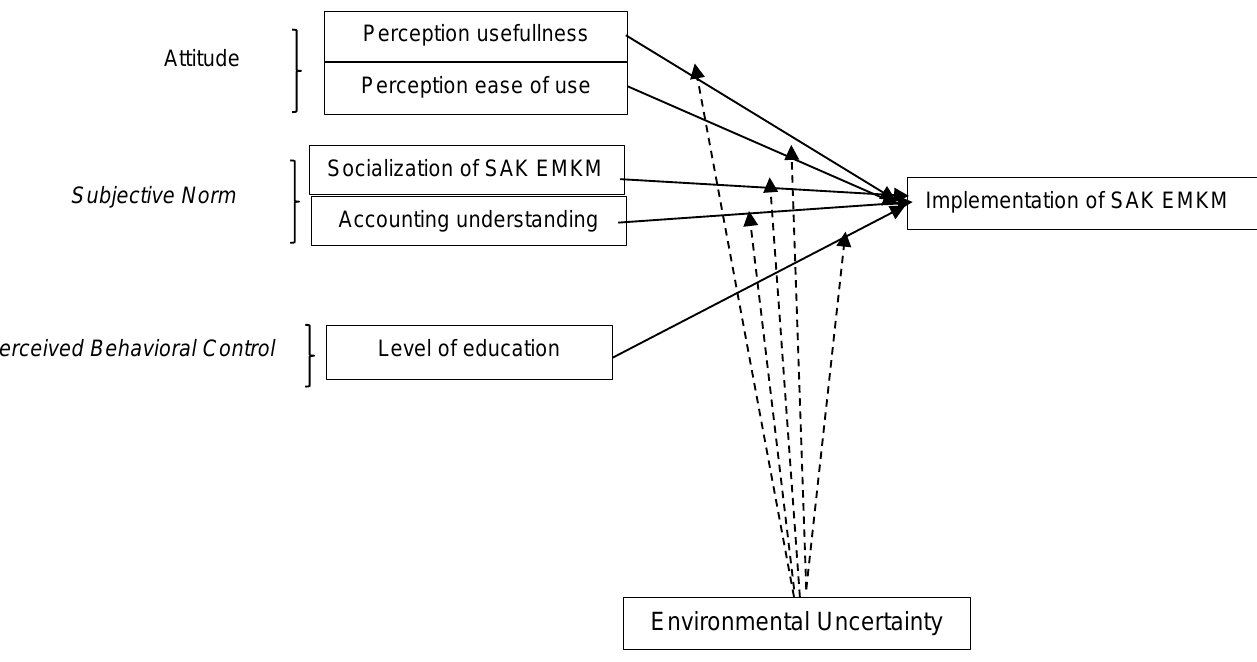
Figure 1: Research conceptual framework (TPB decomposition modifed) Source: Ajzen